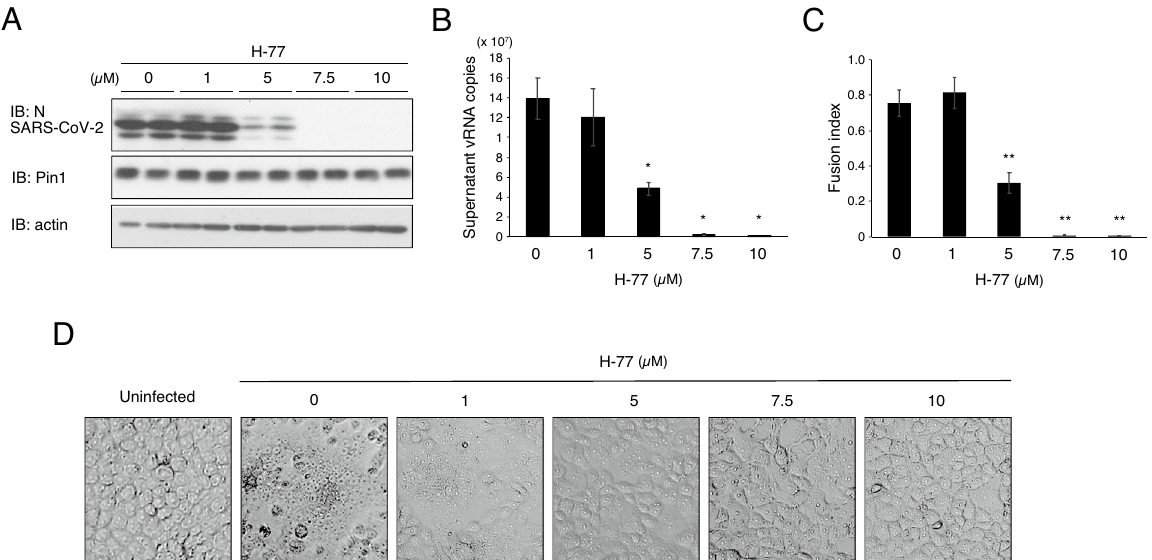
Figure 2. Pin1 inhibitor H-77 inhibits SARS-CoV-2 proliferation in a concentration-dependent manner. VeroE6/TMPRSS2 cells were pretreated with the indicated concentrations of H-77 for 2 h, and were subjected to SARS-CoV-2 infection (MOI of 0.01) followed by incubation for 24 h in the presence of the same concentrations of H-77. ( A ) Western blotting of cell lysates (Duplicate in the figure) with SARS-CoV-2 N, Pin1, and actin antibodies. Full-length blots are presented in Supplementary Fig. 4. ( B ) vRNA copies contained in 5 µL of the supernatant were quantified by RT-qPCR using authorized SARS-CoV-2 N primers (n = 3). ( C ) Fusion index calculated by counting numbers of cells and nuclei of infected cells after Giemsa straining. Approximately 100 nuclei and cell number per field were counted for each of five fields. Error bars indicate standard deviation. * P < 0.05, ** P < 0.01, Mann–Whitney U test, compared with 0 µM (DMSO). ( D ) Representative images of SARS- CoV-2-infected VeroE6/TMPRSS2 cells at 24 h post-infection with the indicated concentrations of